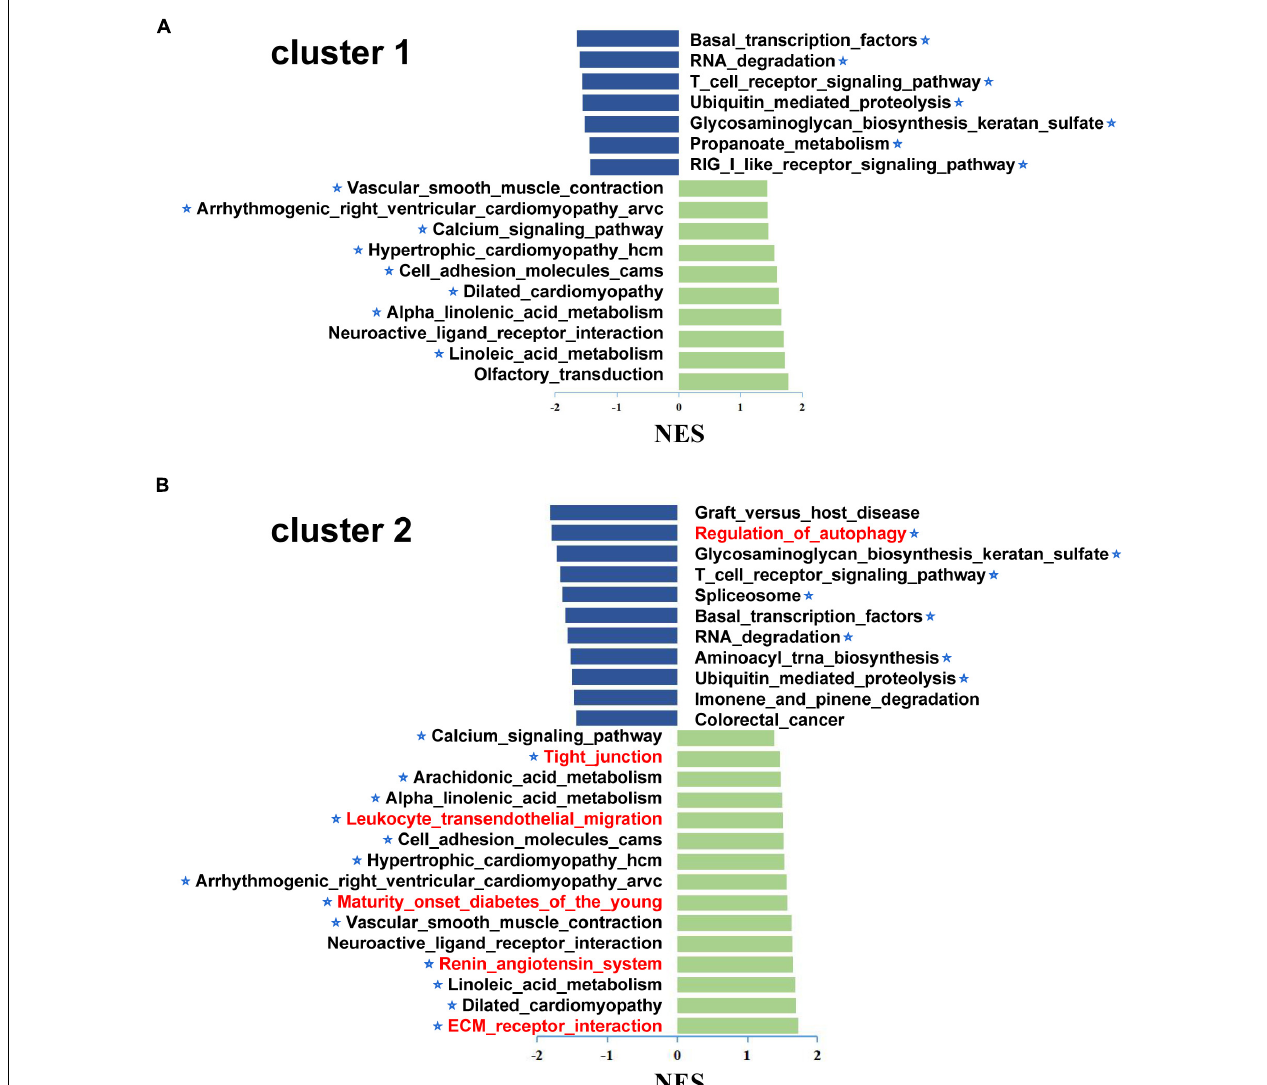
FIGURE 7 | The Gene set enrichment analysis (GSEA) of different subgroup in the CAD samples. GSEA was used to explore the differences between the biological pathways of cluster 1 (A) and cluster 2 (B) ; x-axis represents the NES and the asterisks denote the pathways associated with cardiovascular disease. In addition, the unique aberrant pathways were marked in red in cluster 2 compared to cluster 1. GSEA, gene set enrichment analysis; NES, normalized enrichment